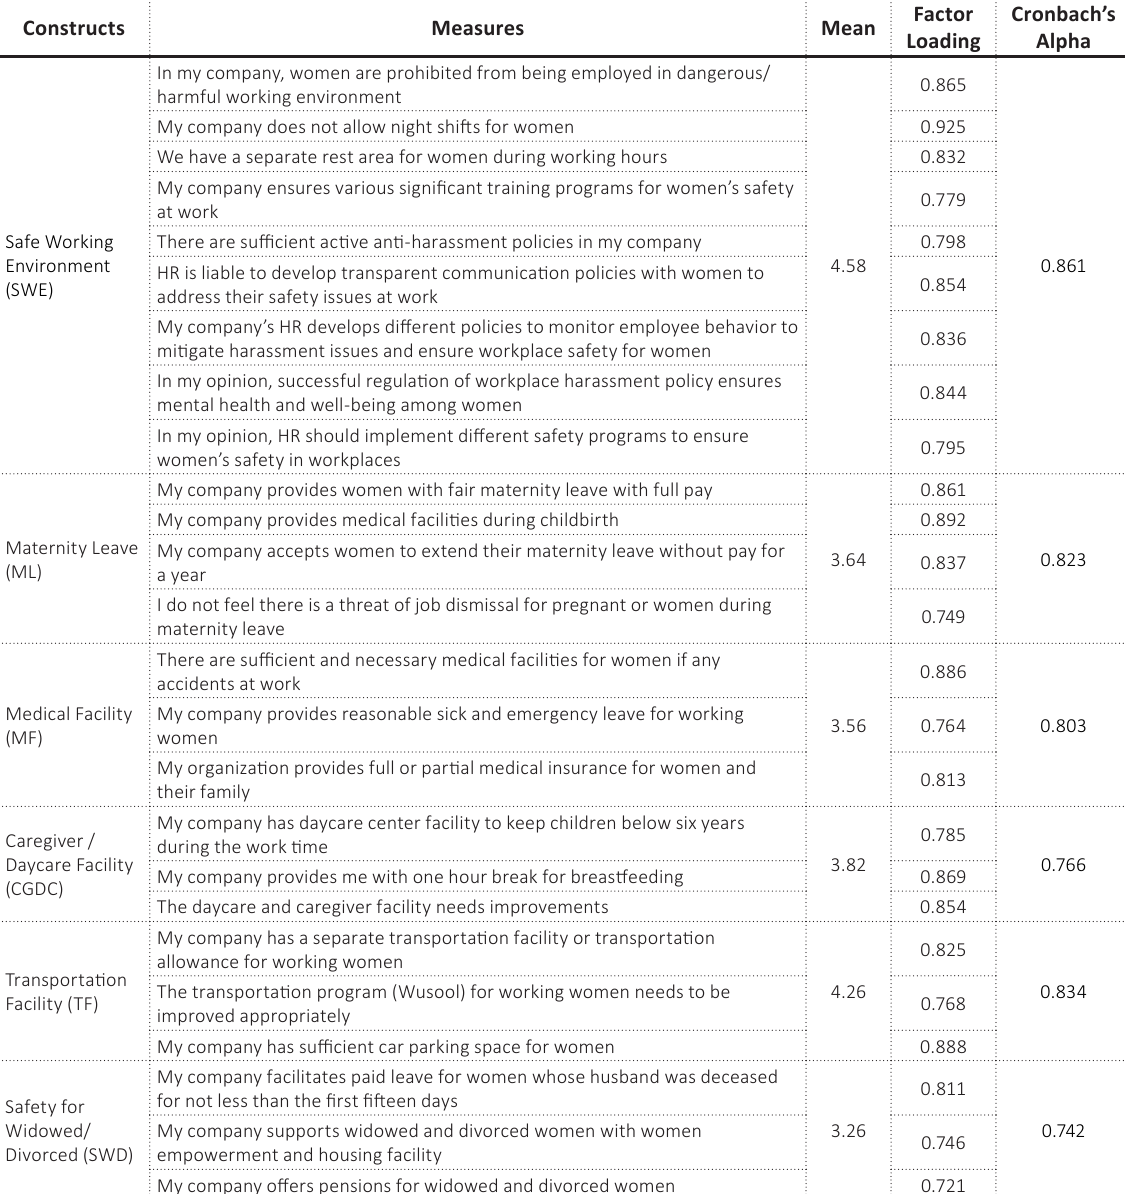
Table 2. Mean, factor loadings, and Cronbach’s alpha